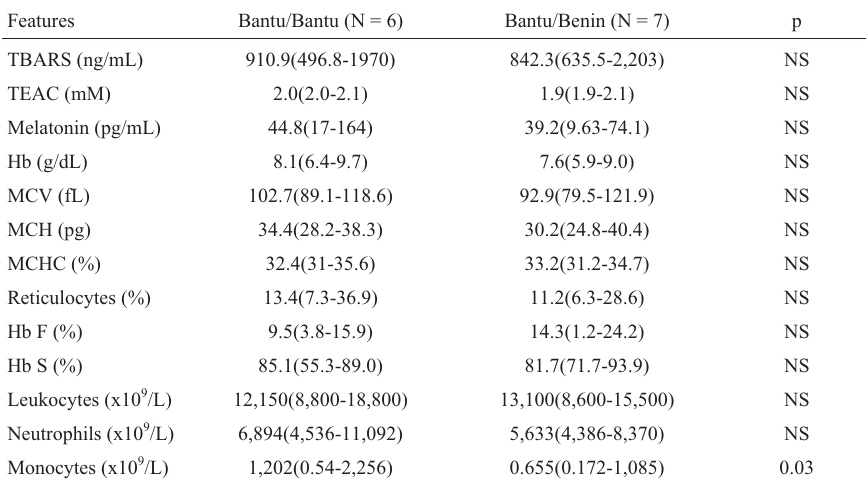
Table 4 - Redox profile and hematological characteristics of SCA patients according to (cid:2) S gene haplotypes, represented by median values (minimum and maximum).